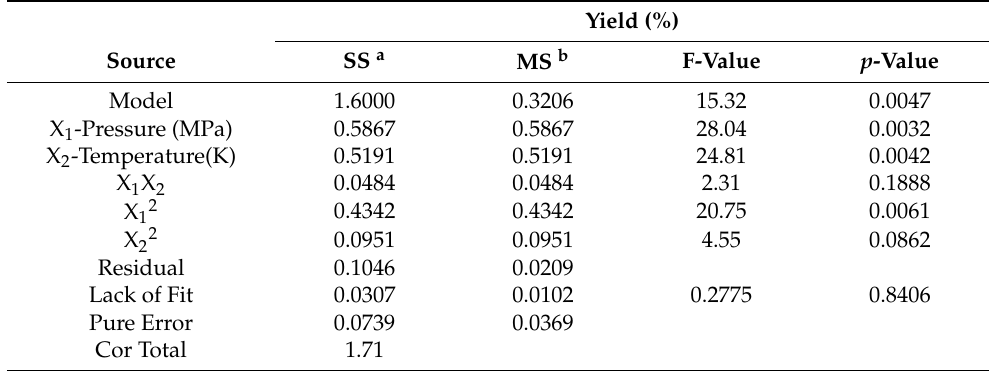
Table 3. ANOVA results on the CCD models selected. Estimated regression model of the relationship between a response variable and the independent variables.